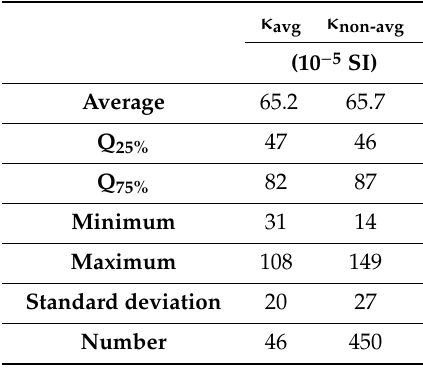
Table 1. Descriptive statistics of measured values of κ non-avg and κ avg